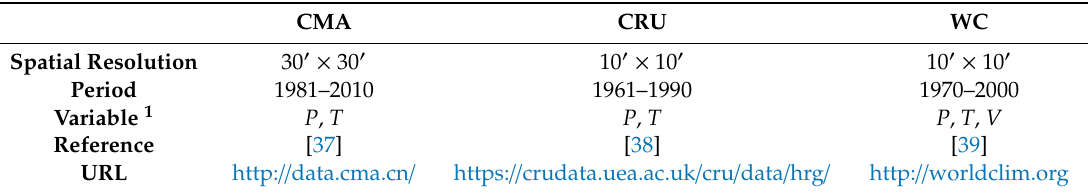
Table 2. Information about meteorological